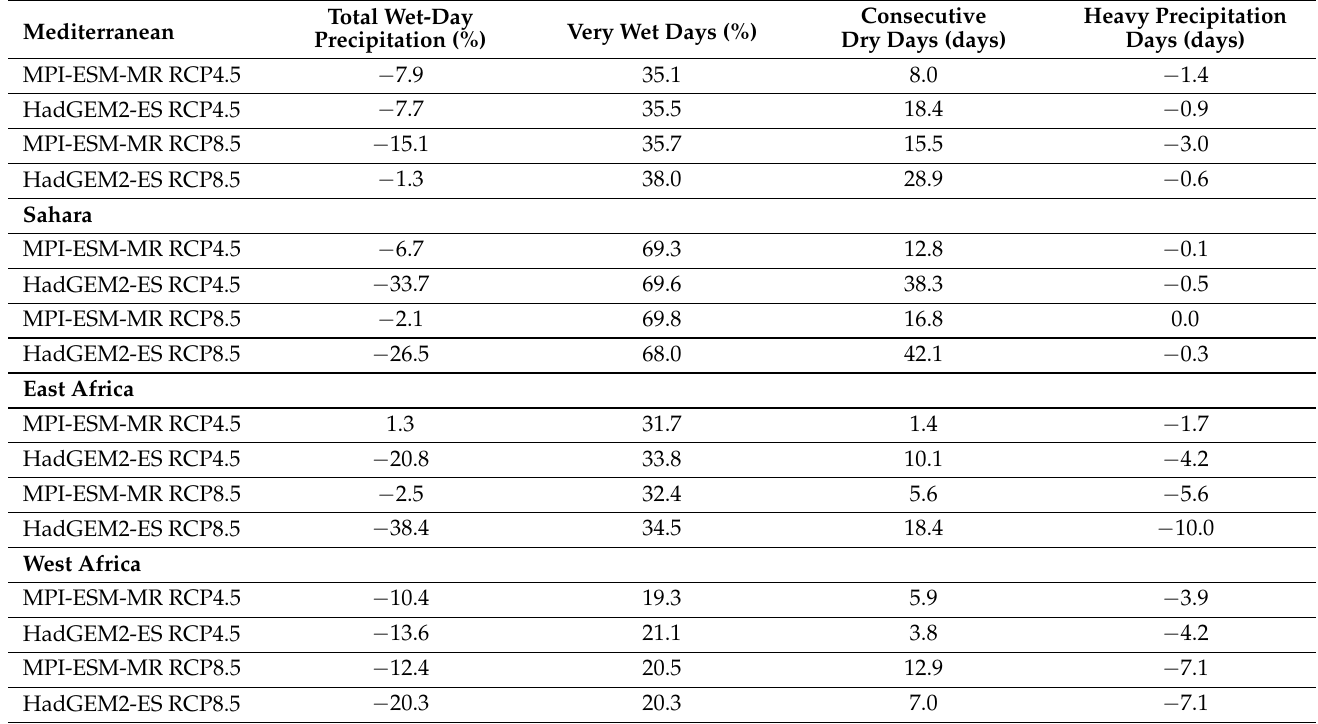
Table 4. The temporally averaged changes in precipitation indices weighted over sub-regions of MENA for the period of 2071–2100 displayed as differences with respect to the reference period